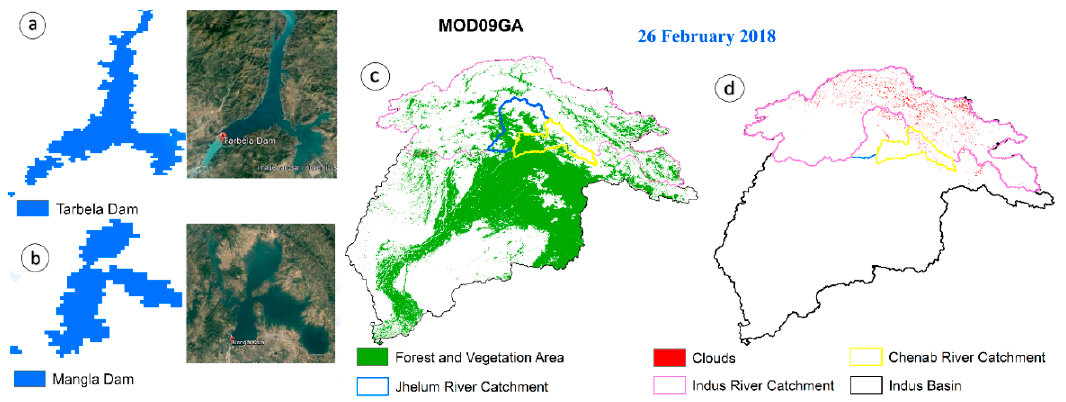
Figure 2. ( a , b ) Water bodies delineation using MODIS daily (MOD09GA) product and comparison with Google Earth imagery. ( c ) Forest and vegetation mask developed using MODIS MOD09GA. ( d ) Blended cloud mask prepared using MODIS (MOD09GA and MOD021km) reflection and thermal bands.